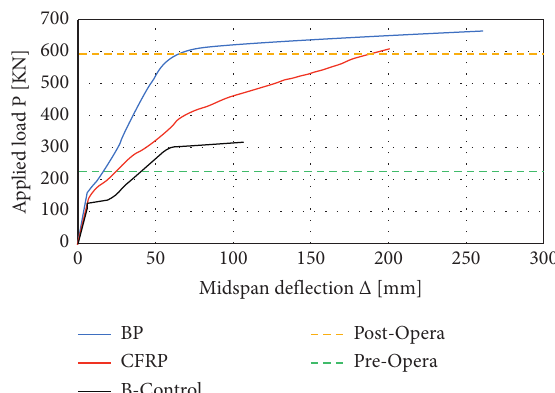
Figure 18: Load vs deflection law: comparison of the